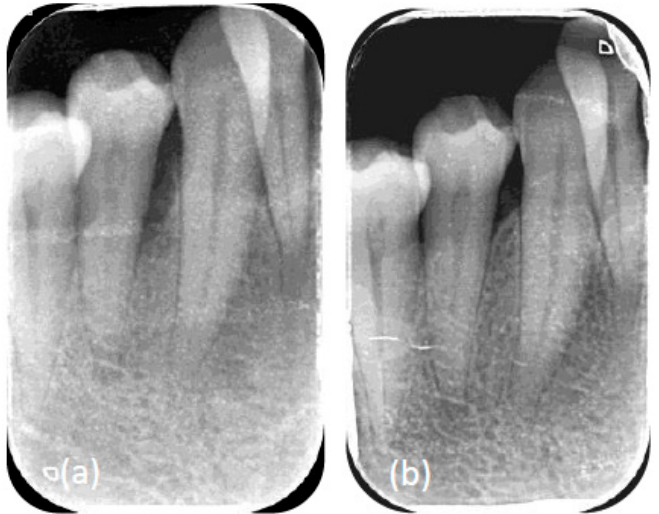
Figure 5. ( a ) Radiographic view of the angular defect 44 M before regenerative intervention. ( b ) Radiographic view of the angular defect mesial of the 44 6 months after the intervention, attesting to a good healing capacity after periodontal surgery.